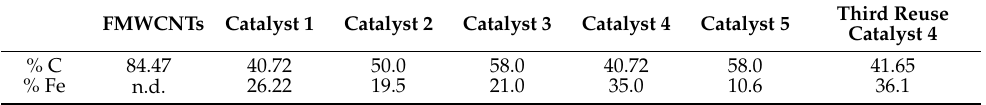
Table 2. Elemental analysis of the materials.